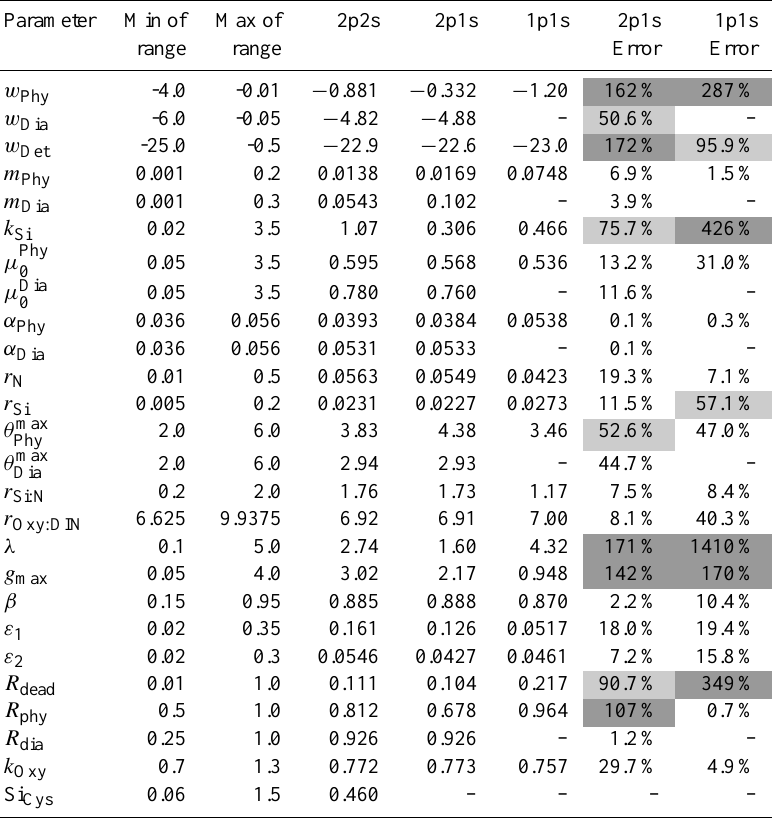
Table 3. Range from which initial model parameter guesses are drawn, optimized parameters and their corresponding a posteriori errors as variance (from Hessian matrix analysis) scaled by parameter values. Errors greater than 100% are highlighted in dark gray, errors greater than 50% are highlighted in light gray.